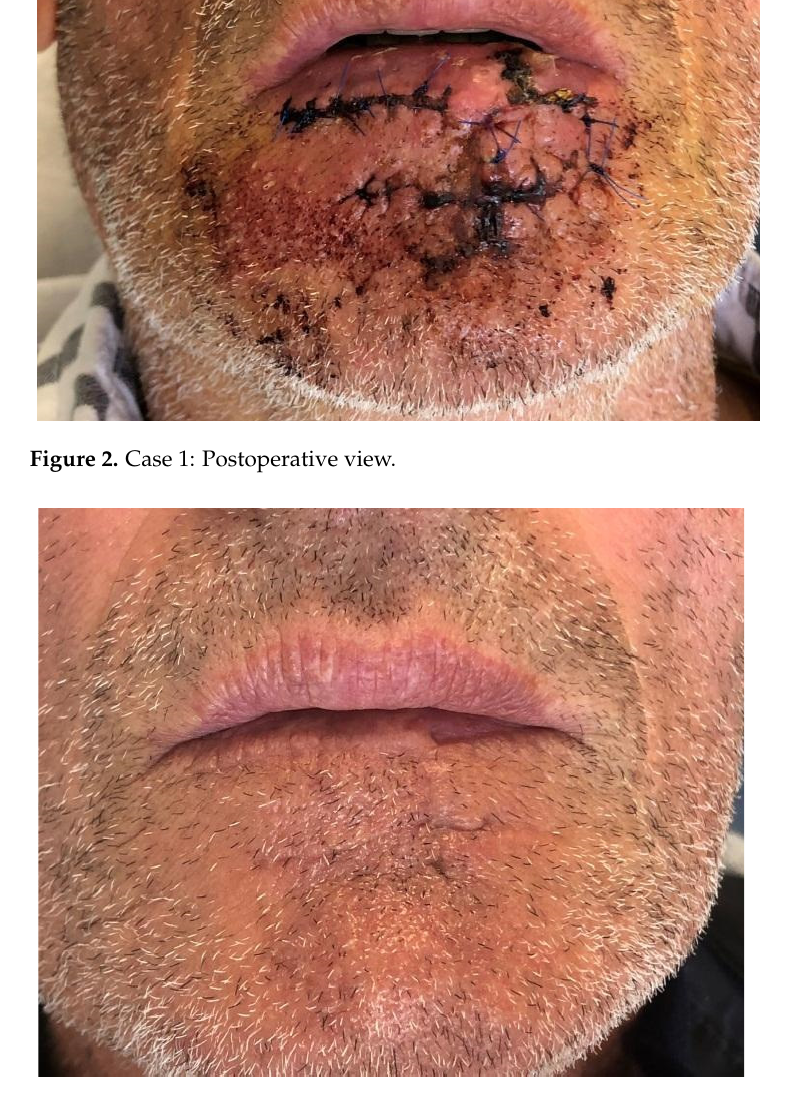
Figure 3. Case 1: Follow up at sixth months. Resting position.